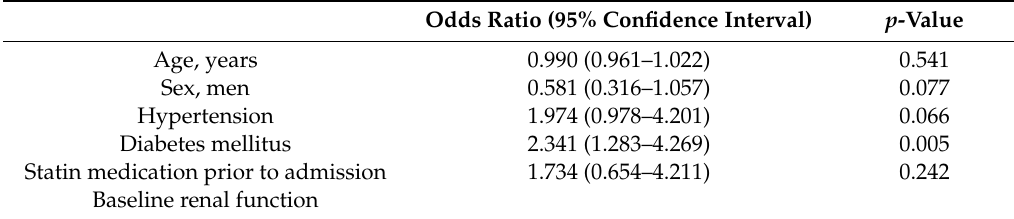
Table 2. Multivariate analysis of factors associated with acute kidney